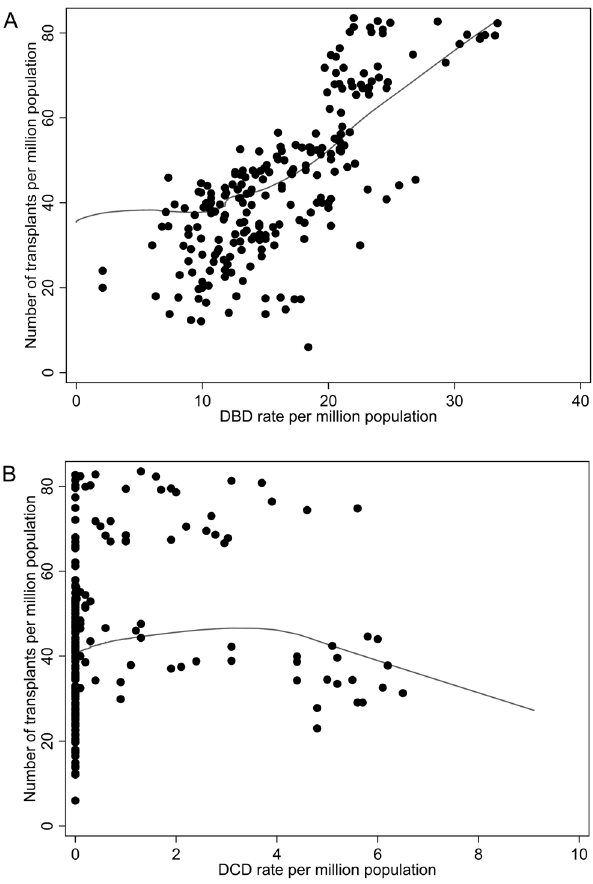
Figure 4. Transplant Rate by (a) Donation after Brain Death (DBD) rate and (b) Donation after Cardiocirculatory Death (DCD) rate. Solid lines are the Lowess curve of the predicted values from the fitted model.